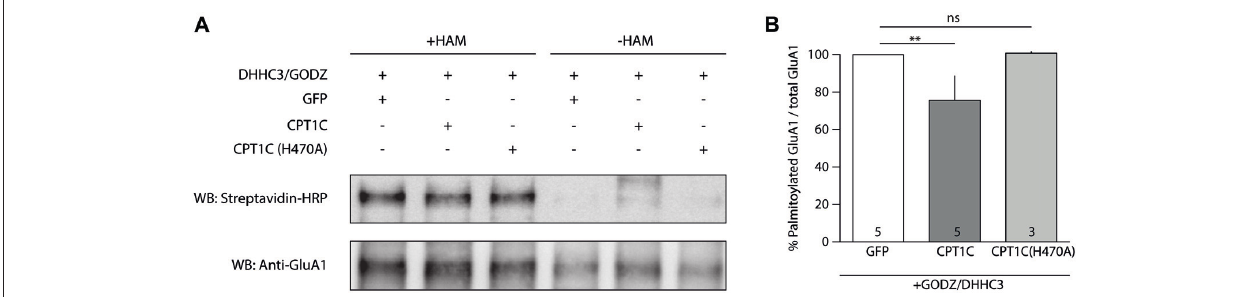
FIGURE 7 | CPT1C acts as depalmitoylating enzyme of GluA1. (A) Palmitoylation levels detected with Acyl-Biotin Exchange (ABE) assay of GluA1 alone (GFP), or together with CPT1C-GFP or CPT1C(H470A) in HEK293AD-GluA1 expressing cells transfected with DHHC3/GODZ palmitoylating enzyme. The biotinylated GluA1 immunoprecipitates subsequent to the ABE assay for all conditions were subjected to SDS-PAGE. Palmitoylation of GluA1 subunit is detected only in plus-hydroxylamine (+HAM) samples (three lanes from the left). − HAM samples control non-specific incorporation of biotin (three lanes from the right). GluA1 palmitoylation levels (right top) were detected by Western blotting with streptavidin-HRP (palmitoylation). The total amount of immunoprecipitated GluA1 was detected by Western blotting with anti-GluA1-NT antibody (anti-GluA1, bottom) after stripping the membranes. (B) Quantification of palmitoylation levels for GluA1 alone (GFP), together with CPT1C or CPT1C(H470A) in HEK293AD cells constitutively expressing GluA1. Ratio of palmitoylated GluA1 to total GluA1 is shown as mean and S.E.M. ( ∗∗ p < 0.01 and ns p > 0.05; Mann-Whitney U test; n = 5, 3 and 3, respectively).